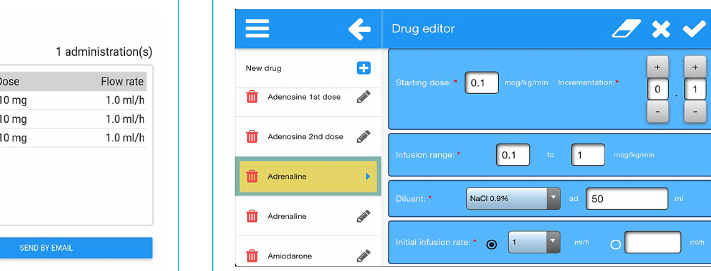
Figure 3: Screenshot of the export activity window.